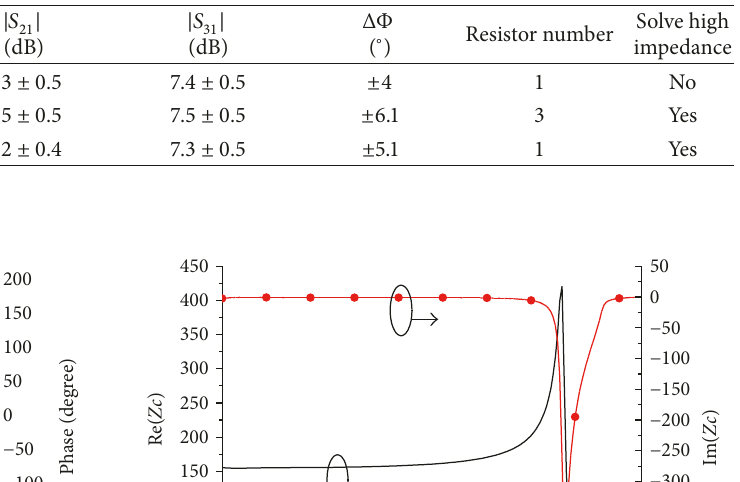
Figure 7: Proposed transmission line of 158.1 Ω . Table 3: Performance comparison of 4 :1 unequal power divider.